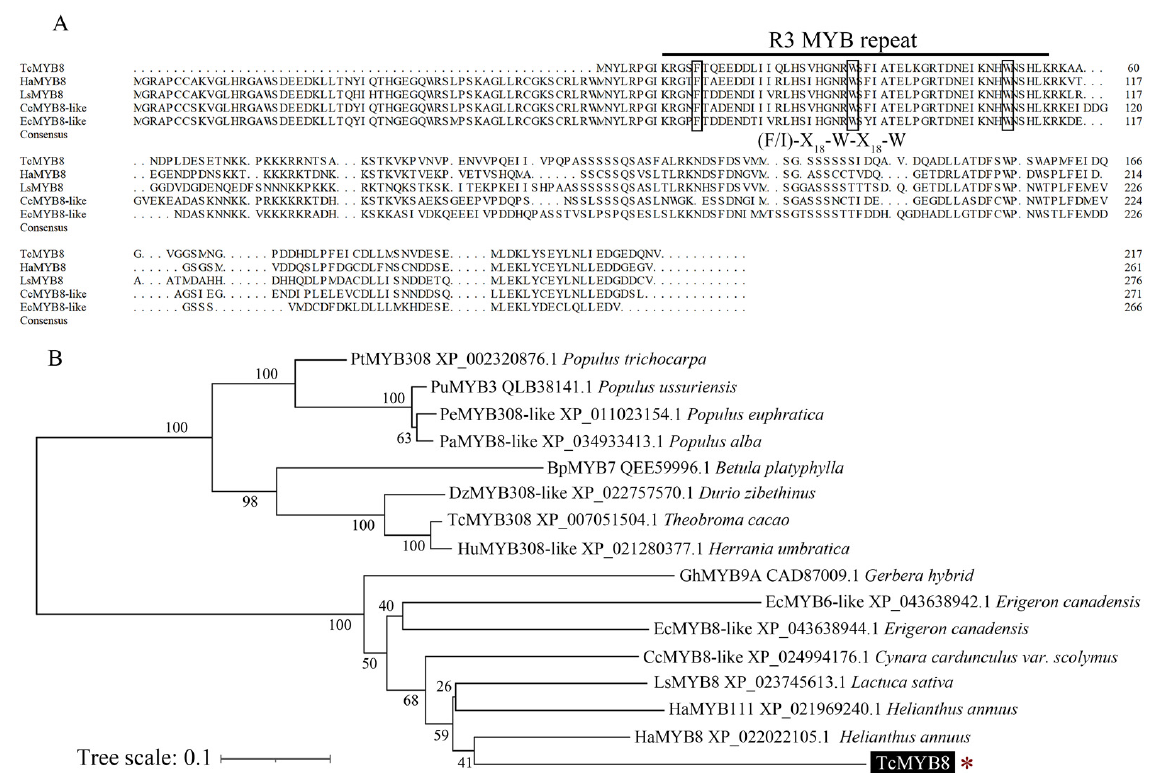
Figure 1. Multiple sequence alignment, conservative domain analysis, and phylogenetic analysis of TcMYB8 and other plant MYB proteins. ( A ) Multiple sequence alignment of the deduced TcMYB8 protein and MYB8 proteins of Helianthus annuus , Lactuca sativa , Cynara cardunculus , and Erigeron canadensis . Solid black line indicates the conserved DNA-binding domainR3 MYB repeat. ( B ) Phy- logenetic analysis of TcMYB8 and MYB subfamily proteins from different plant species. Multiple sequence alignment was carried out using ClustalW, and the phylogenetic tree was constructed us- ing MEGAX64 with the neighbor-joining method of 1000 bootstrap replications. * represents MYB8 protein in T. cinerariifolium .